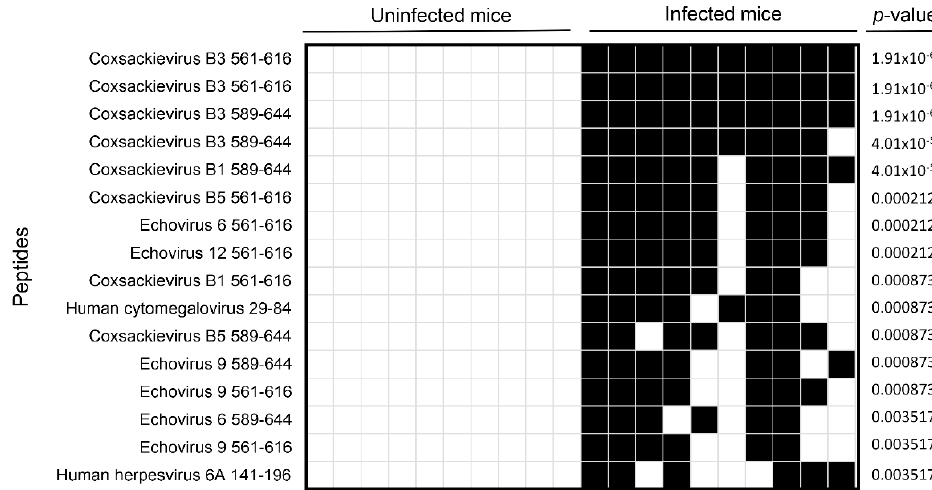
Figure 1. Viral peptides identified by VirScan. Sera collected from CVB3-infected or control animals were subjected to PhIP-Seq as described in the methods section. Differential abundance of antibody reactivities to viral peptides were determined in the corresponding groups using the EdgeR software, and the data were compared between groups using Barnard’s exact test. Each column represents one animal. Blank and filled squares represent absence and presence of antibody reactivities, respectively ( n = 10 animals per group).